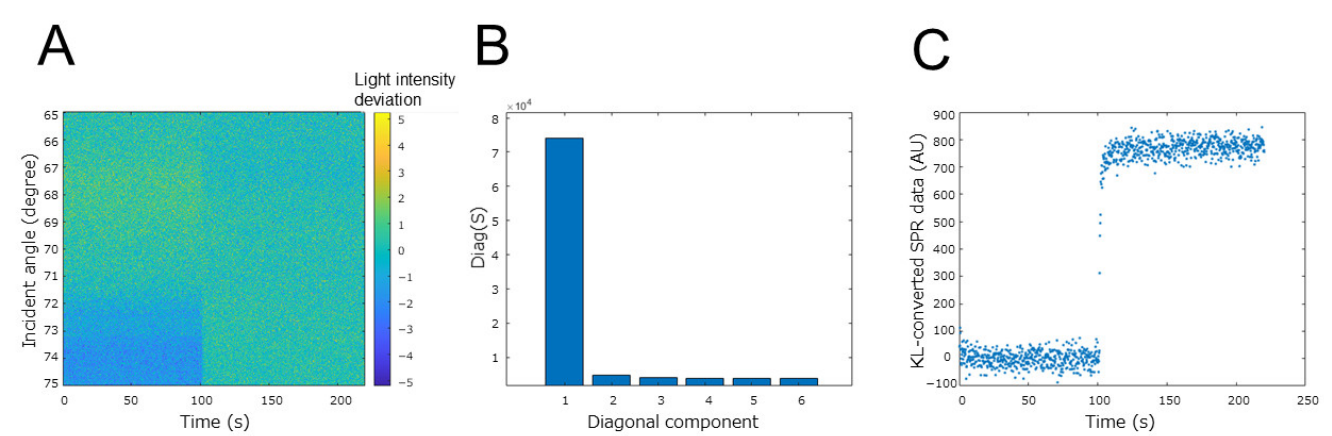
Figure 5. Feature quantity analysis obtained by KL conversion of image data of SPR curve. ( A ) SPR data deviation obtained from the completely oxidized and completely reduced states of the SPR curves. ( B ) Diagonal matrix obtained by KL conversion. ( C ) KL-converted SPR